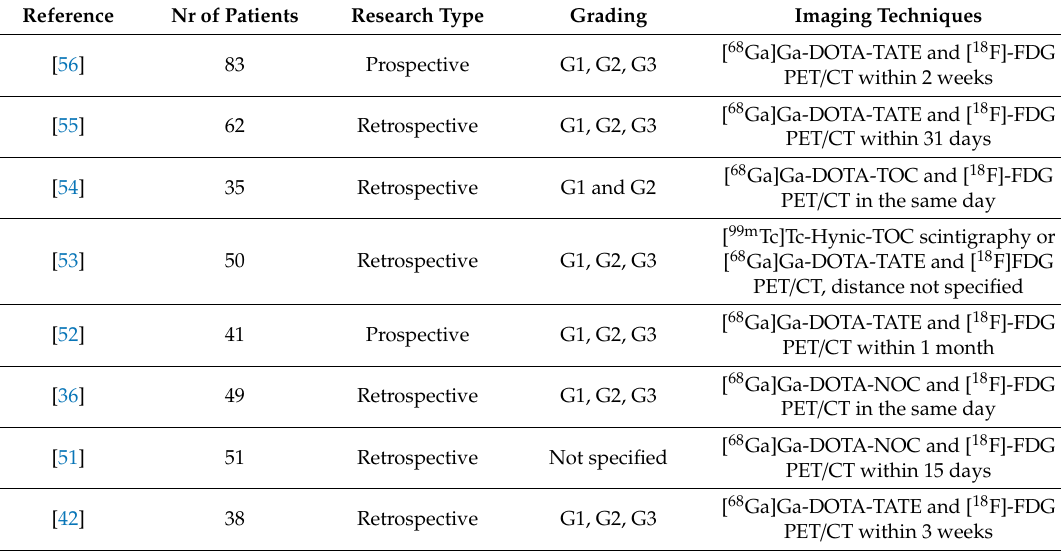
Table 2. Characteristics of selected